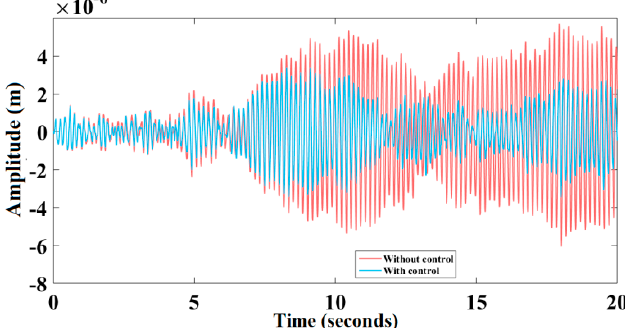
Figure 14. White noise response (Sensors in FE3, Q = 10 10 , R = 1, Gc = 100).